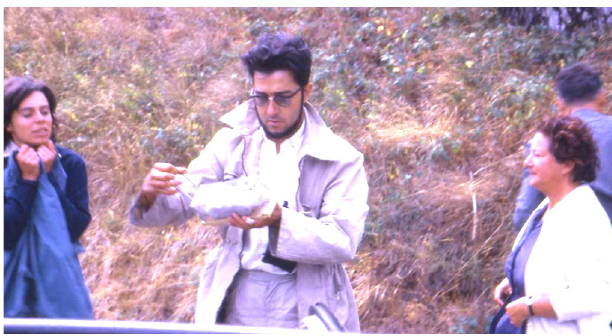
Figure 2. Jean-Antoine Rioux sampling in the fi eld with Yvonne Campana-Rouget (right) & Françoise Deltour.